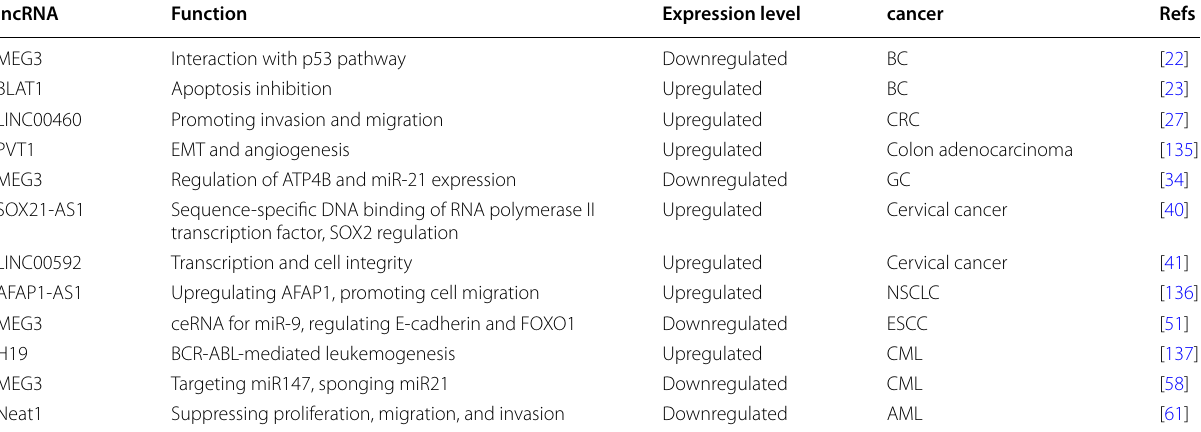
Table 2 Effect of DNA methylation on lncRNA expression lncRNA